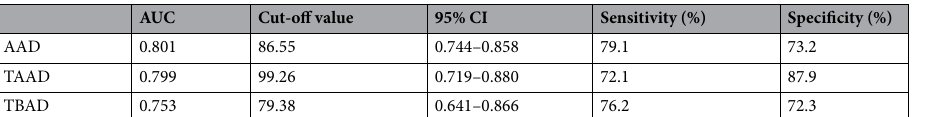
Table 8. Diagnostic value of IMA for predicting in-hospital mortality. IMA, ischemic modified albumin; AUC, area under the curve; CI, confidence interval, AAD, acute aortic dissection; TAAD, Stanford type A aortic dissection; TBAD, Stanford type B aortic